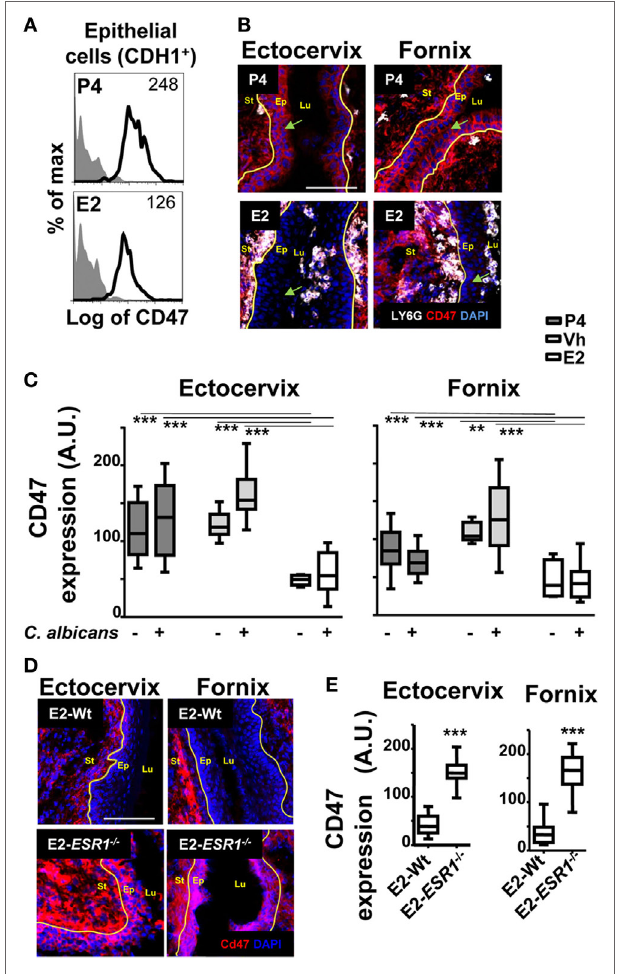
FigUre 6 | CD47 expression in the female reproductive tract (FRT). Hormone-treated ovariectomized mice were mock or Candida albicans inoculated in the vagina. (a) Representative flow cytometry plots of the lower FRT epithelial cells from hormone-treated mice ( n = 3). (B) FRT with indicated anatomical regions stained for CD47 (red) or neutrophils (white). (c) CD47 expression in the basolateral epithelium. Data were calculated in at least three different points in three different sections of each sample ( n = 5). (D) Estradiol treated ESR1 − / − and Wt mice challenged with C. albicans . Representative photographs of ectocervix and fornix stained with CD47 (red) and (e) quantification ( n = 5). Data are expressed as box and whiskers 10–90 percentile. ** p < 0.01 and *** p < 0.001 Mann–Whitney. Isotype control mAb (gray filled lines) and indicated mAb (lines). Yellow line indicates the lamina propia. Scale bar, 200 µm. Abbreviations: E2, estradiol; Vh, vehicle; P4, progesterone. Lu, lumen; Ep, epithelium; St, stroma; A.U., arbitrary units.